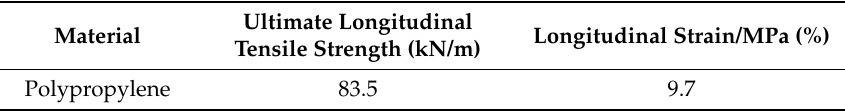
Table 2. Properties of the geogrid.